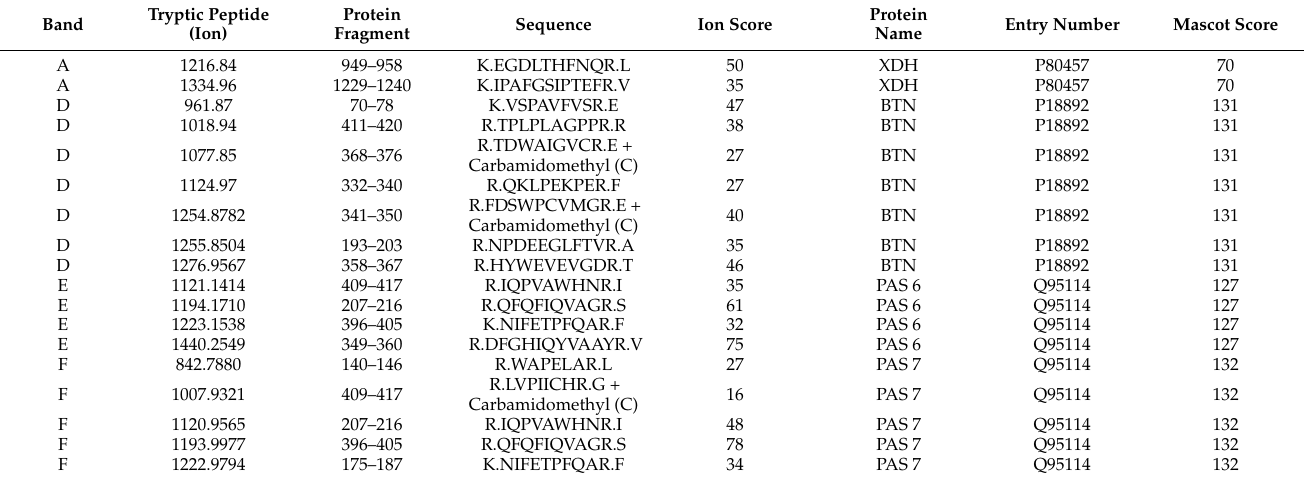
Table 5. Identification of MFGM proteins via in-gel digestion of electrophoretic